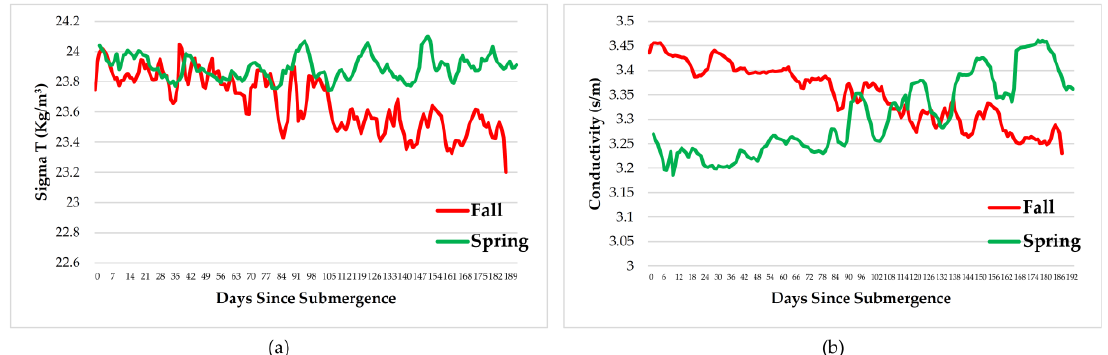
Figure 6. Daily average density as Sigma T ( a ) and conductivity ( b ) over the duration of the experiments at a depth of 170 m in the Strait of Georgia in spring and fall (Ocean Network Canada’s VENUS observatory).